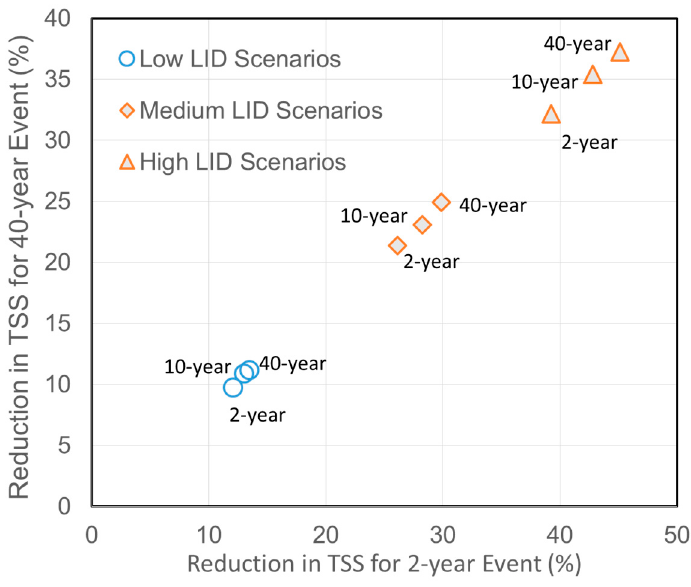
Figure 9. Trade-off between performance of LID strategies for 2- and 40-year events; label indicates the event that was used to optimize a solution.